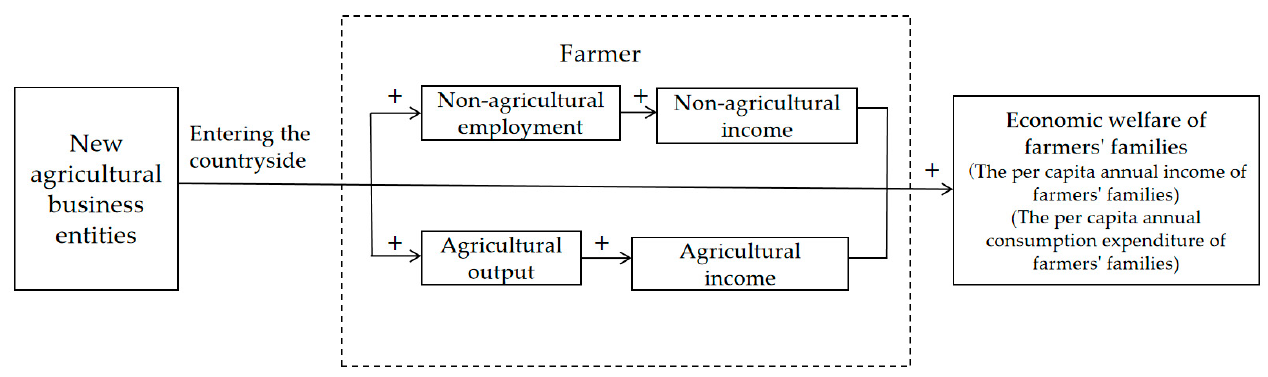
Figure 1. A theoretical framework of the influence of new agricultural business entities on the economic welfare of farmers’